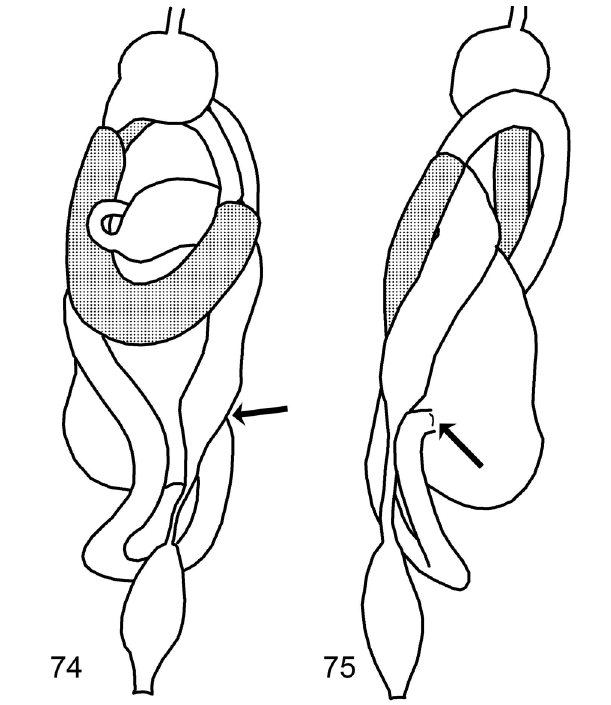
Figs 74–75. Worker gut of Cylindrotermes parvignathus in 74- dorsal and 75- right view (arrows: P1-P3